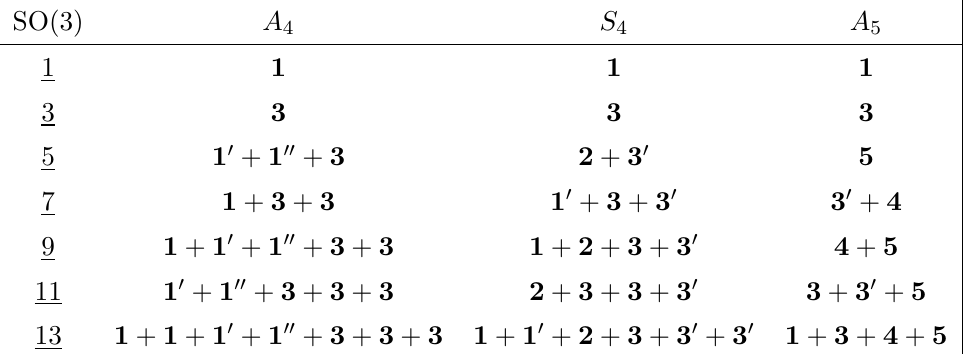
4 , S 4 and A 5 . Results of decom-